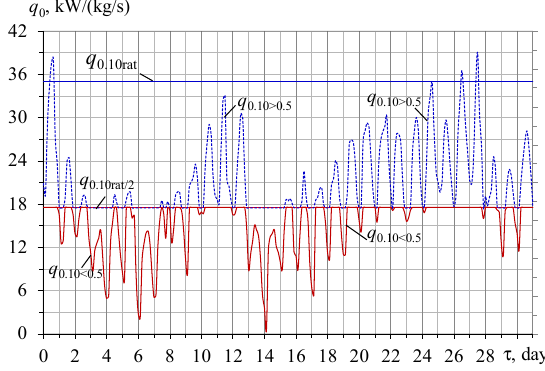
Figure 3. Actual values of specific refrigeration capacities q 0.10 required for outdoor air conditioning to 10 ° С , a part load q 0.10>0.5 of q 0.10 within a range of refrigeration capacity regulated from q 0.10rat/2 to q 0.10rat and the rest part q 0.10 ˂ 0.5 within the unregulated range from 0 to q 0.10rat/2 : q 0.10rat/2 = 0.5, q 0.10rat ; q 0.10 = q 0.10>0.5 + q 0.10 ˂ 0.5 , where q 0.10>0.5 is marked for q 0.10 > 0.5 q 0.10rat , and q 0.10 ˂ 0.5 for q 0.10 < 0.5 q 0.10rat .